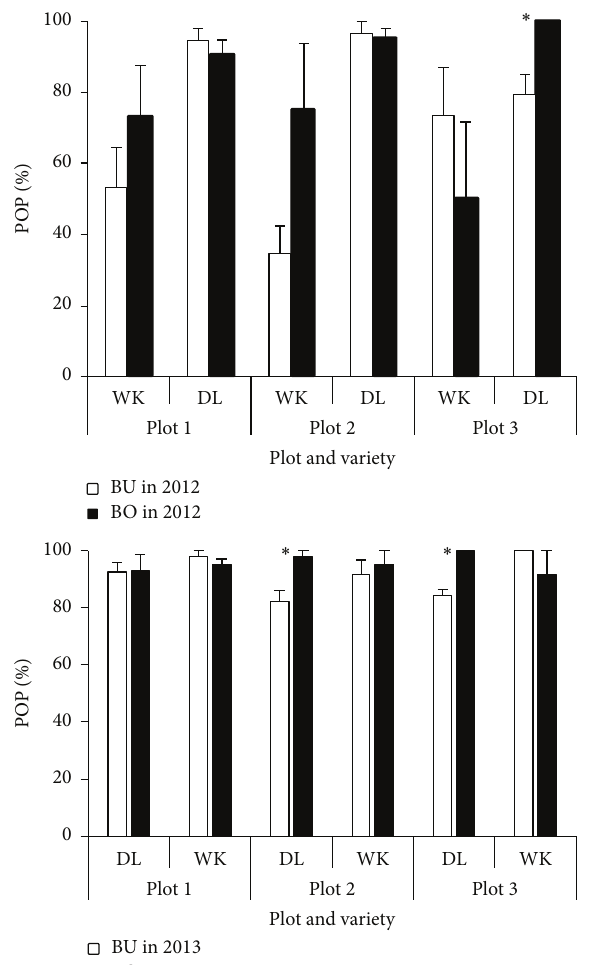
Figure 2: Percentage of overwintered plants (POP) of two napier- grass varieties on June 9, 2012, and on May 27, 2013. For both plots and varieties, refer to Figure 1. ∗ shows the difference between BU and BO areas at 5% level.